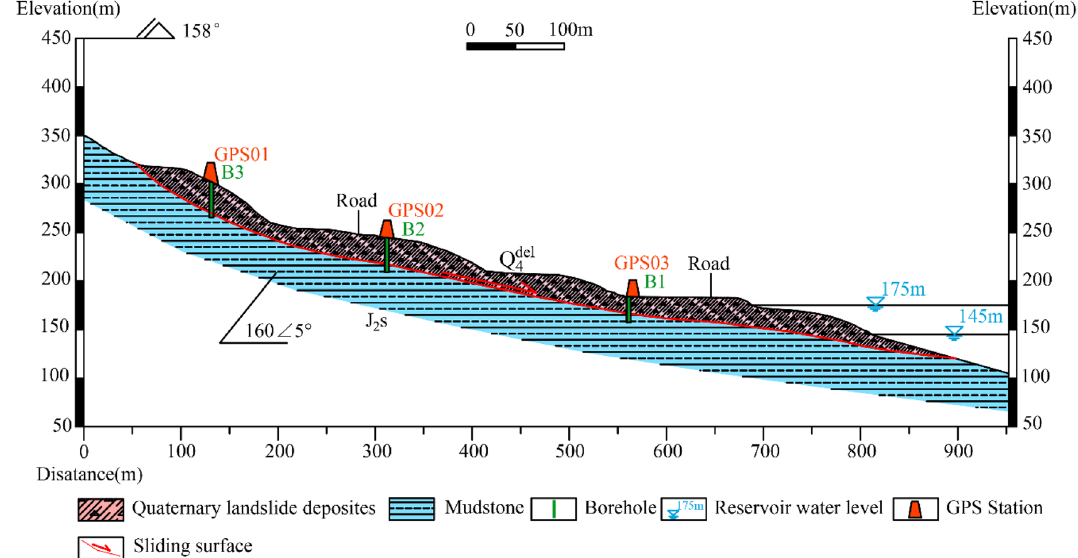
Figure 3. Engineering geological profile 1–1’ of the Sifangbei landslide.